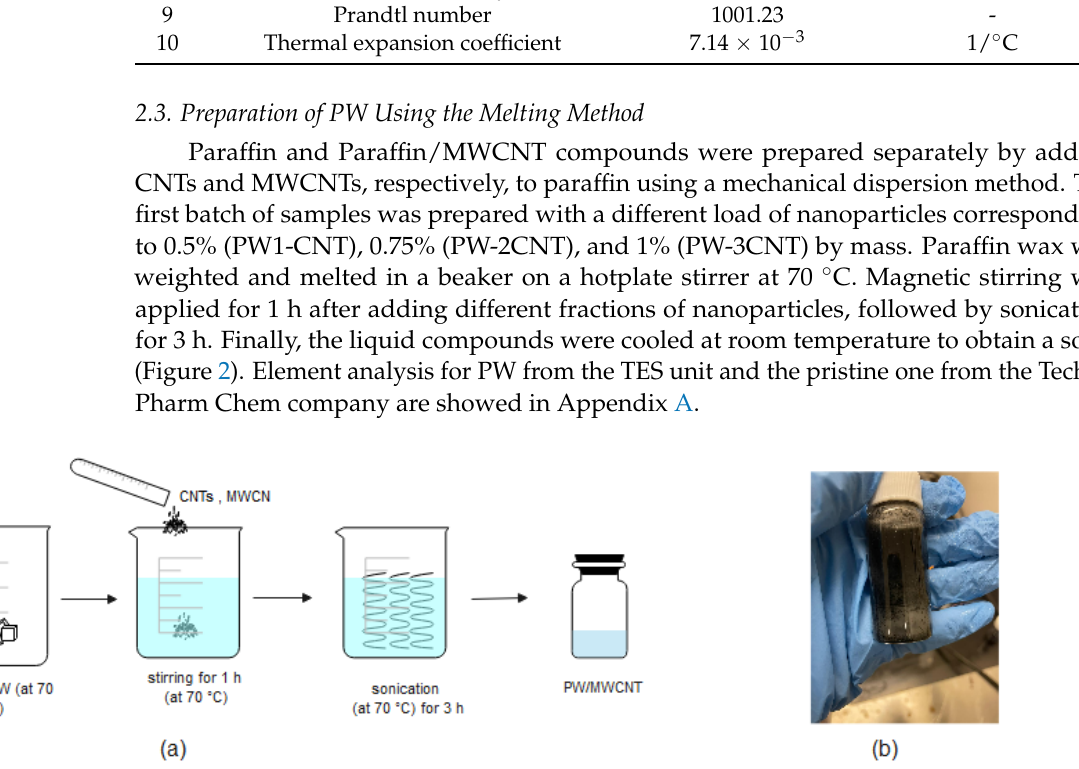
Figure 2. ( a ) Sample preparation using the mechanical dispersion method. ( b ) Final product following sample preparation of PCM with MWCNT.